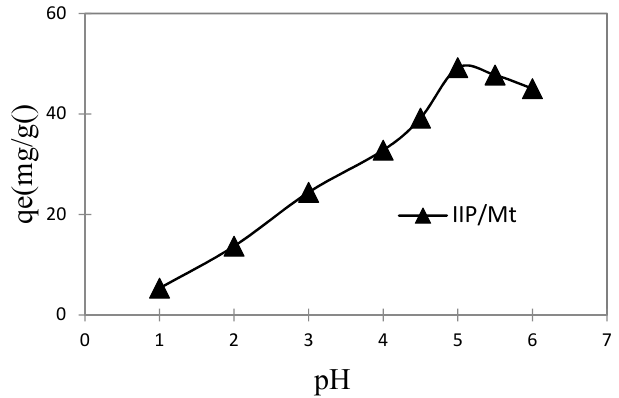
Figure 4. Effect of pH on adsorption capacity of IIP/Mt. Cu 2+ initial concentration: 20 mg/L; adsorption time: 2 h; IIP/Mt: 4 mg; room temperature.